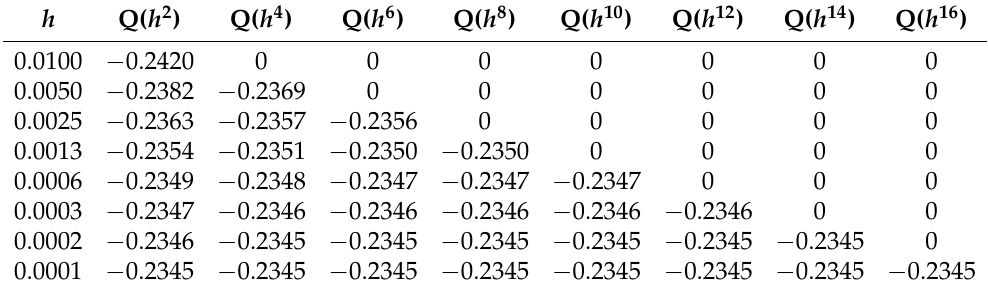
Table 9. The numerical result when α = 0.35 using our central formula with Richardson extrapolation.